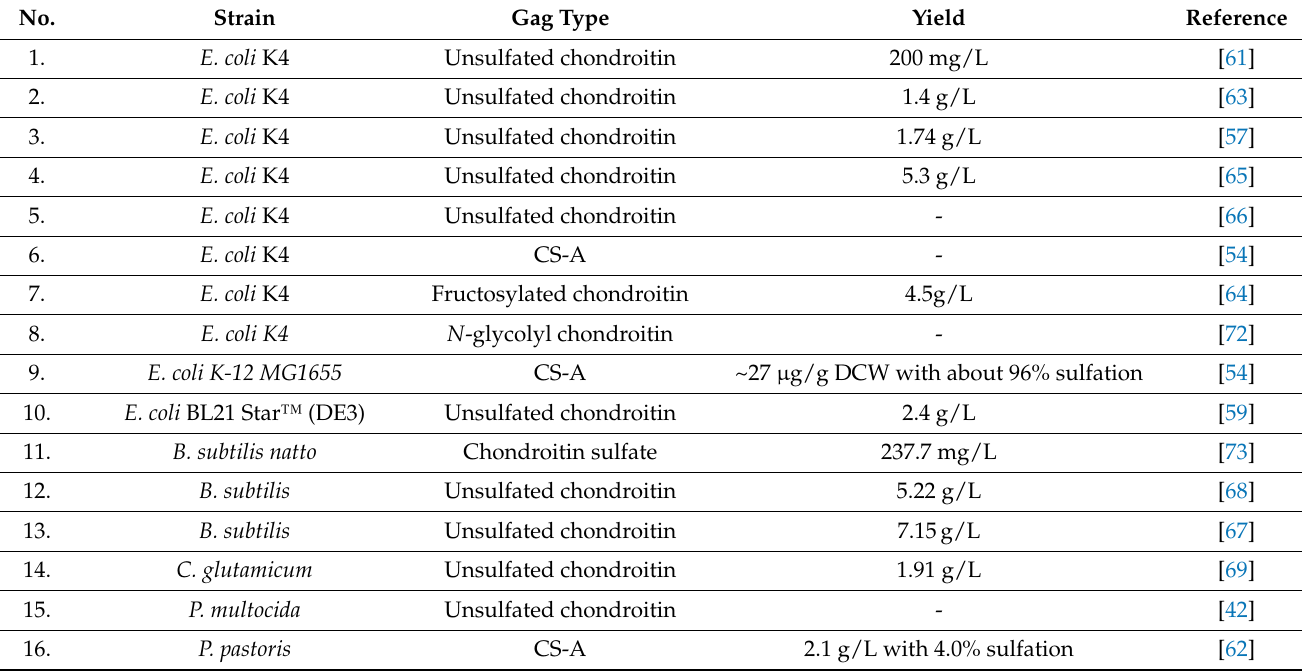
Table 1. Bioengineered microbes used in the synthesis of chondroitin and its